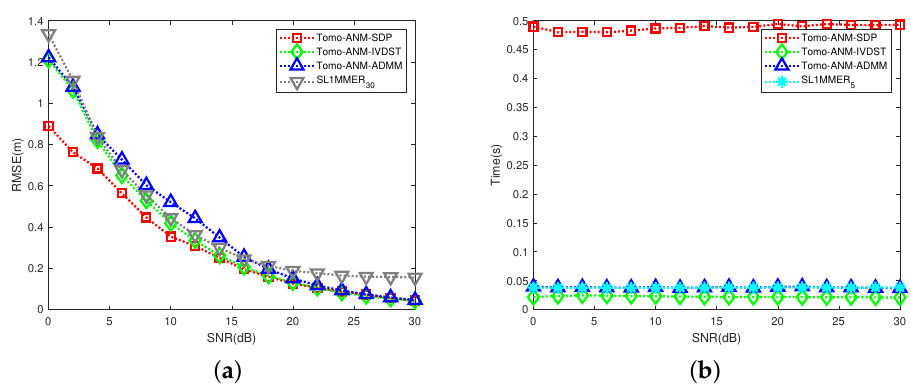
Figure 17. Simple comparisons between Tomo-ANM-IVDST and Tomo-ANM-ADMM. Results of Tomo-ANM-SDP and SL1MMER are shown as a reference. ( a ) Location accuracy. ( b ) Time